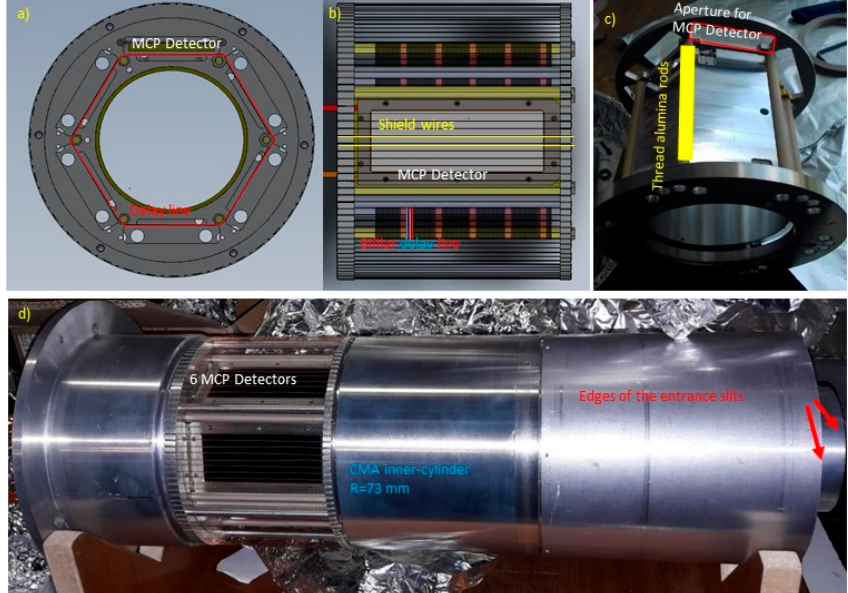
Figure 2. ( a , b ) The drawing of the detector. ( c ) hexagonal holder for the 0.5 mm threaded alumina rod on which the bifilar delay line is coiled. ( d ) The cylindrical mirror analyzer (CMA) inner cylinder with detectors installed. Longitudinal wires at the same potential allow the electrons to reach the micro-channel plates (MCP). The whole system is inserted in the CMA analyzer. Electrical connections (MCP polarization, delay line) go out on the left side of the image.